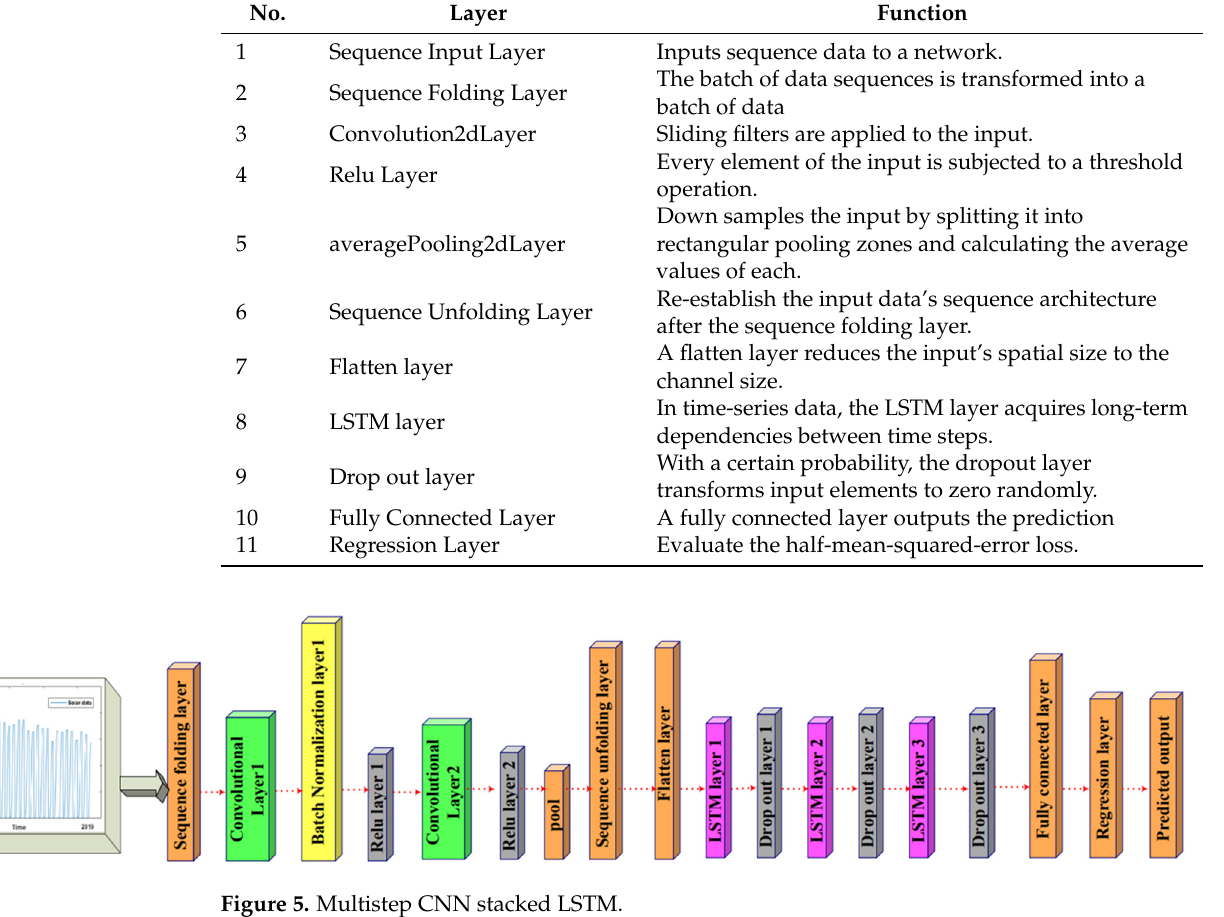
Figure 5. Multistep CNN stacked LSTM.